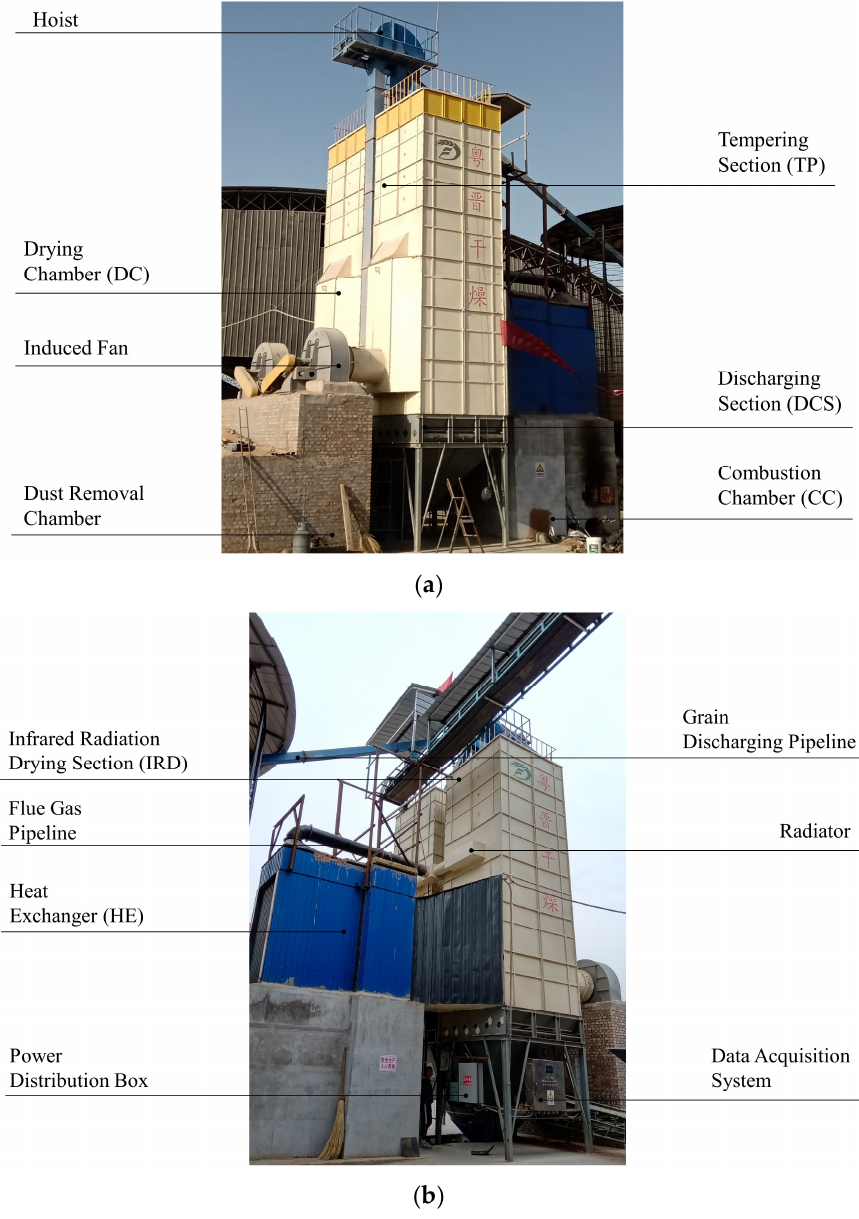
Figure 2. Diagram of the IRCC corn dryer. ( a ) Front; ( b ) rear.